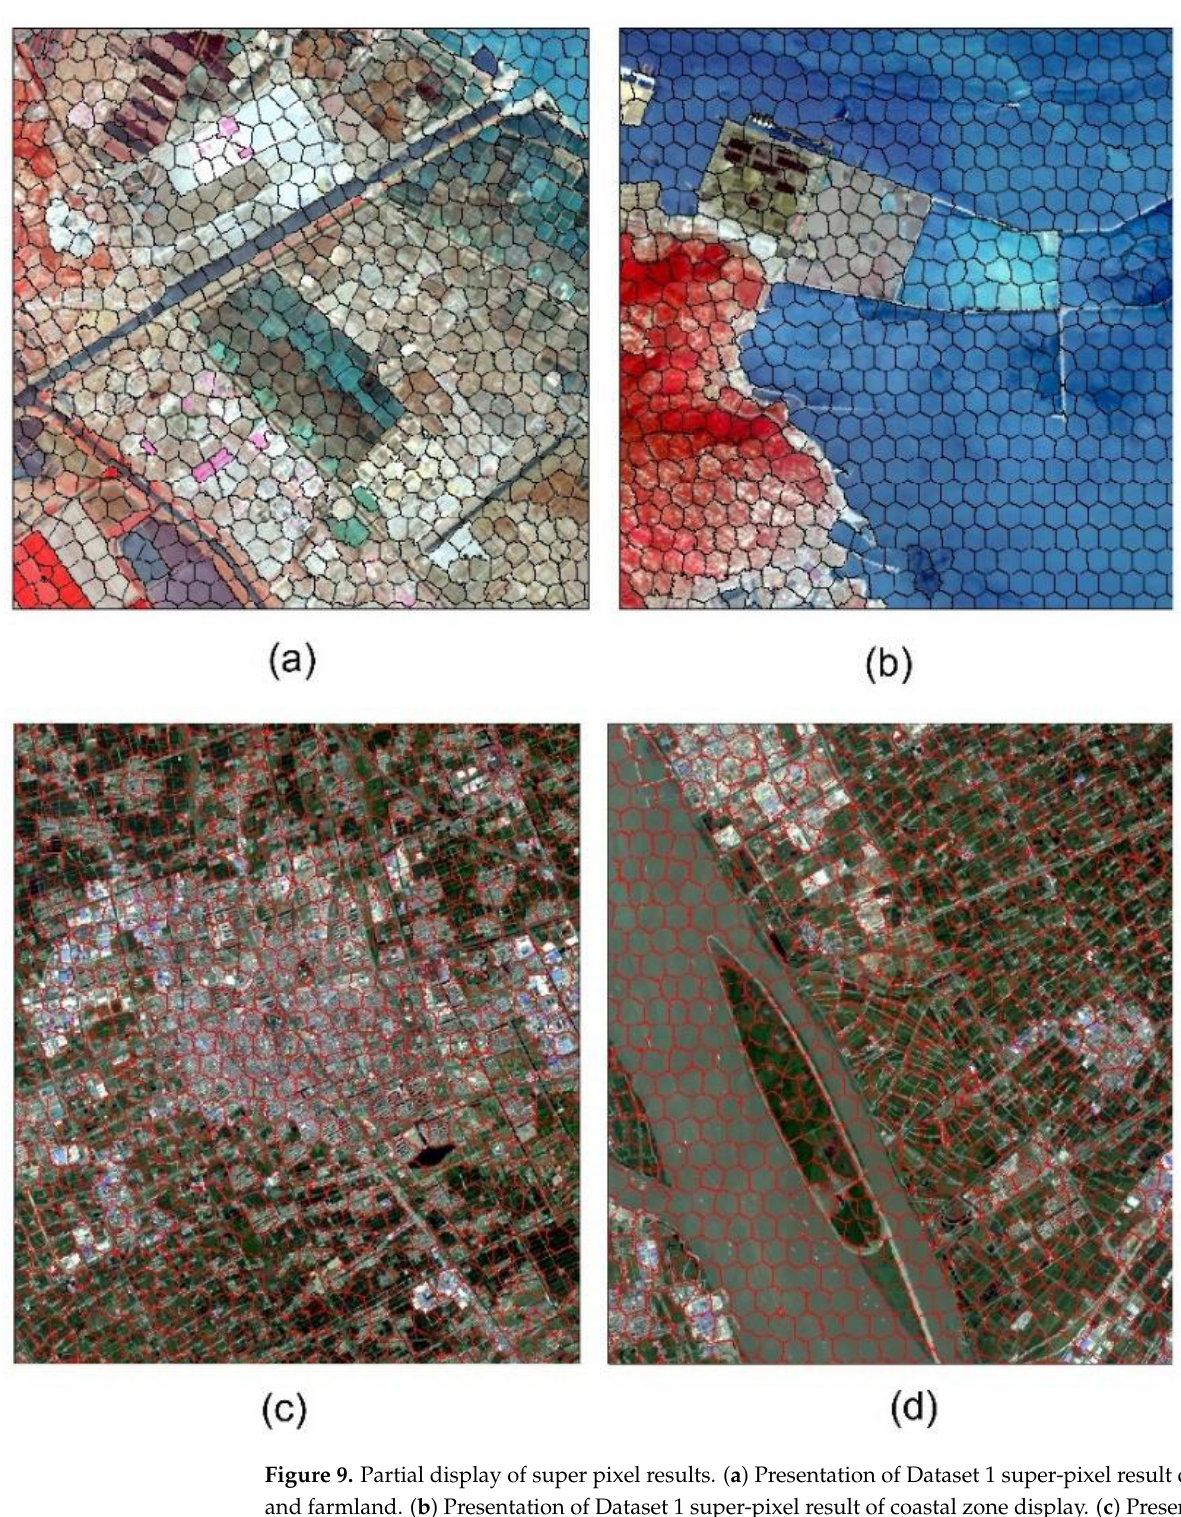
Figure 9. Partial display of super pixel results. ( a ) Presentation of Dataset 1 super-pixel result of road and farmland. ( b ) Presentation of Dataset 1 super-pixel result of coastal zone display. ( c ) Presentation of Dataset 2 super-pixel result of the rivers in a city. ( d ) Presentation of Dataset 2 super-pixel result of the city’s